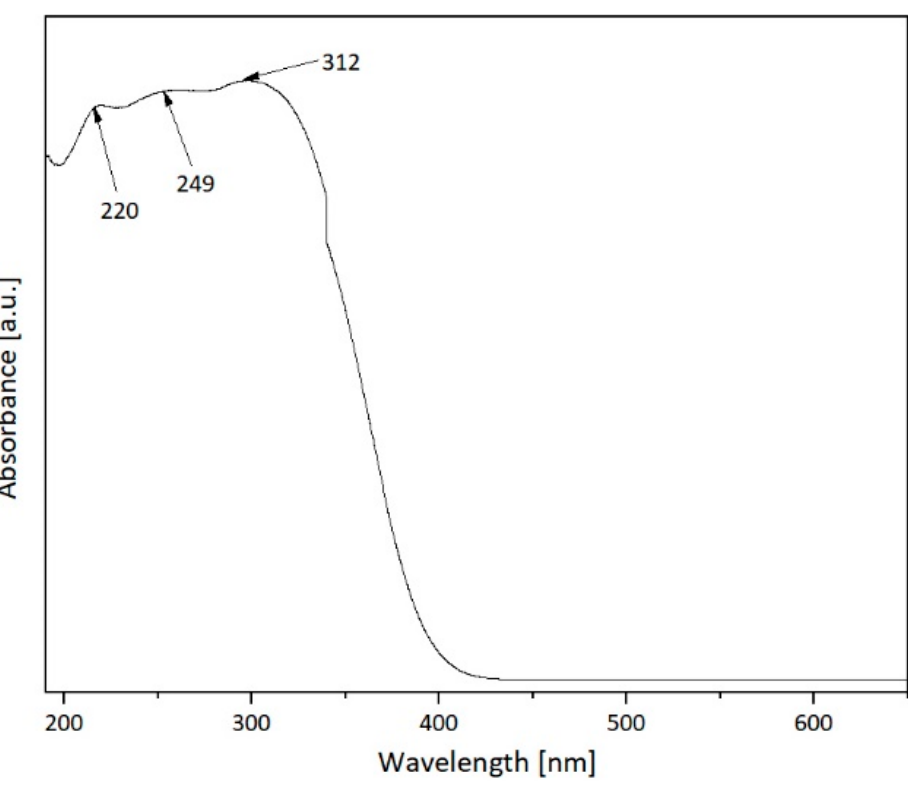
Figure 7. UV-Vis (Ultraviolet–Visible) spectrum of the Ti-SBA-16 material. Ultraviolet and visible (UV-Vis) light spectroscopy enabled confirmation of the introduction of titanium in the catalyst structure (Figure 7). In the UV-Vis spectrum, characteristic absorption bands can be observed at 220 and 249 nm, which confirm the incorporation of titanium into the silica structure. In addition, the wide band at 312 nm indicates the presence of titanium oxide (anatase) in the pores of the catalyst. The UV-Vis spectrum for the Ti-SBA-16 catalyst is consistent with the literature data [37]. The FTIR (Fourier-Transform Infrared) spectroscopy analysis confirmed the structure of the synthesized material. The FTIR spectrum of Ti-SBA-16 (Figure 8) shows the absorption bands characteristic for titanium silicate materials. The band at 445 cm − 1 is attributed to deformation bending vibrations of the Si–O–Si groups during which the angle between bonds changes, and symmetrical valence vibrations during which the bond lengths change. The band at 789 cm − 1 indicates the presence of amorphous silica. Another band (962 cm − 1 ) confirms the incorporation of titanium into the silica structure. It is associated with the isomorphic substitution of Si by Ti ions and is attributed to the stress of polar Si-O-Ti bonds or the presence of the Ti=O group (titanyl group) in the silica material. The band at 1062 cm − 1 is attributed to the presence of Si-O-Si bonds occurring in the